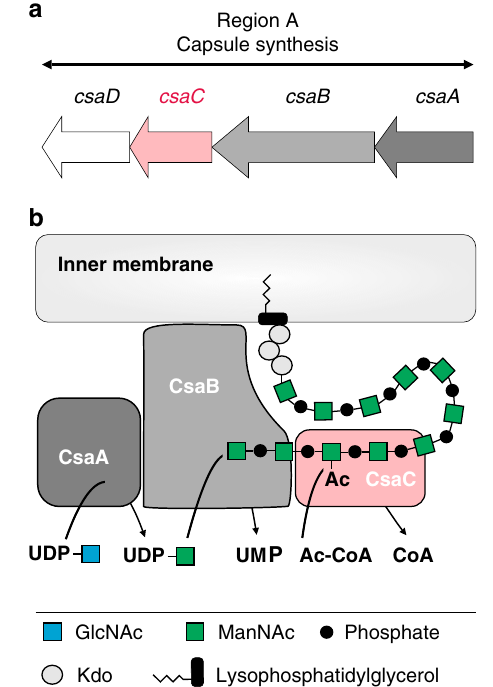
Fig. 1 Capsule biosynthesis in Neisseria meningitidis serogroup A. a Schematic representation of region A of the capsule gene cluster of